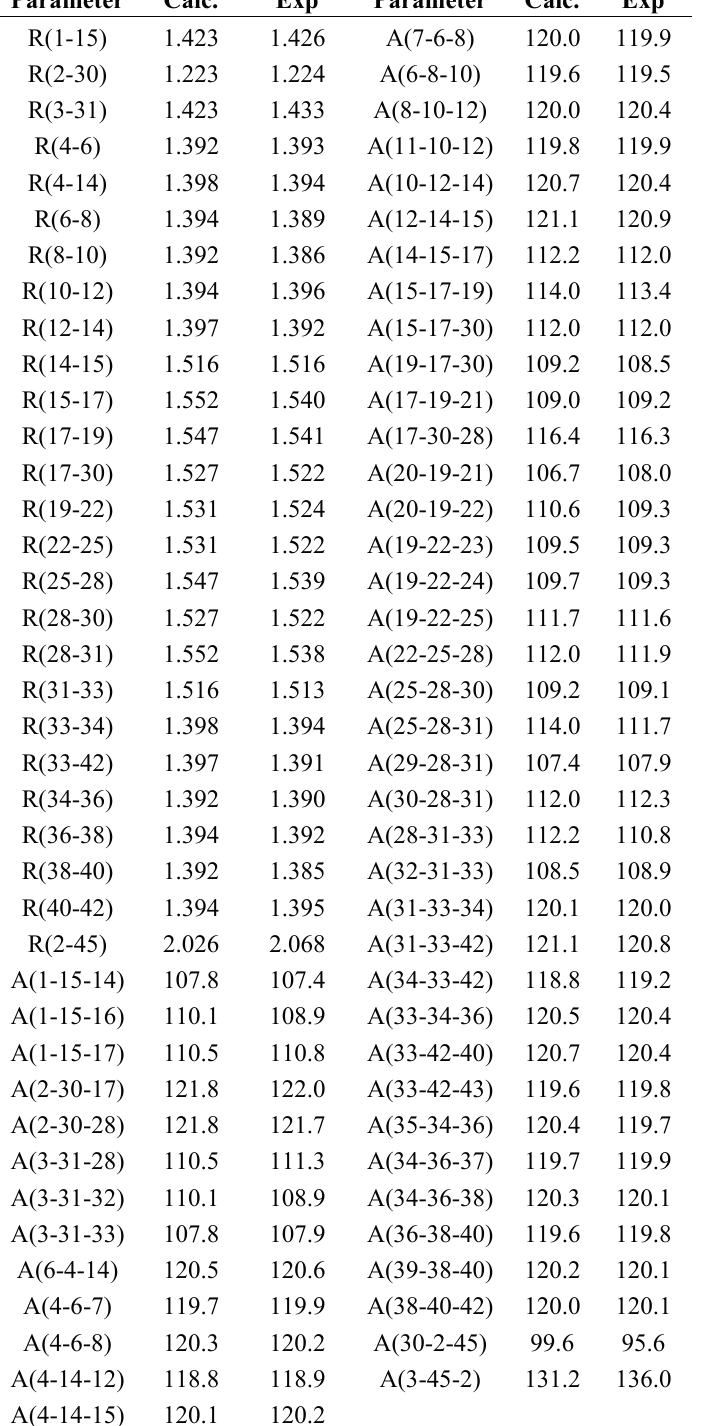
Table 3. The calculated and experimental geometric parameters of the studied compound using the DFT B3LYP/6-311G(d,p)